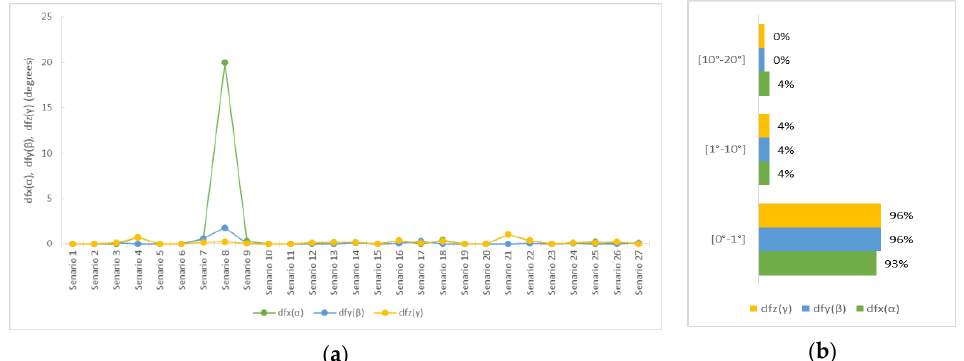
Figure 8. ( a ) Deviations for rotation angles per axis in the quaternion method. ( b ) Histogram of the deviations for rotation angles per axis in the quaternion method.